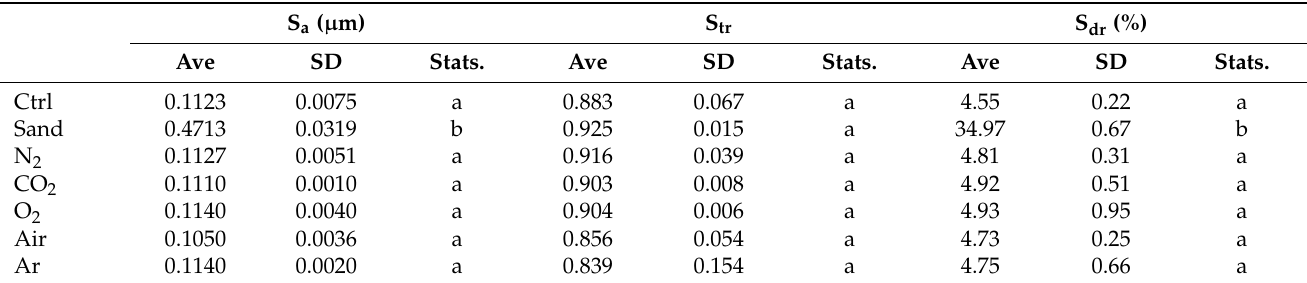
Table 1. Surface roughness parameters of zirconia after sandblasting or plasma irradiation using different gas species ( n = 3 for each group).